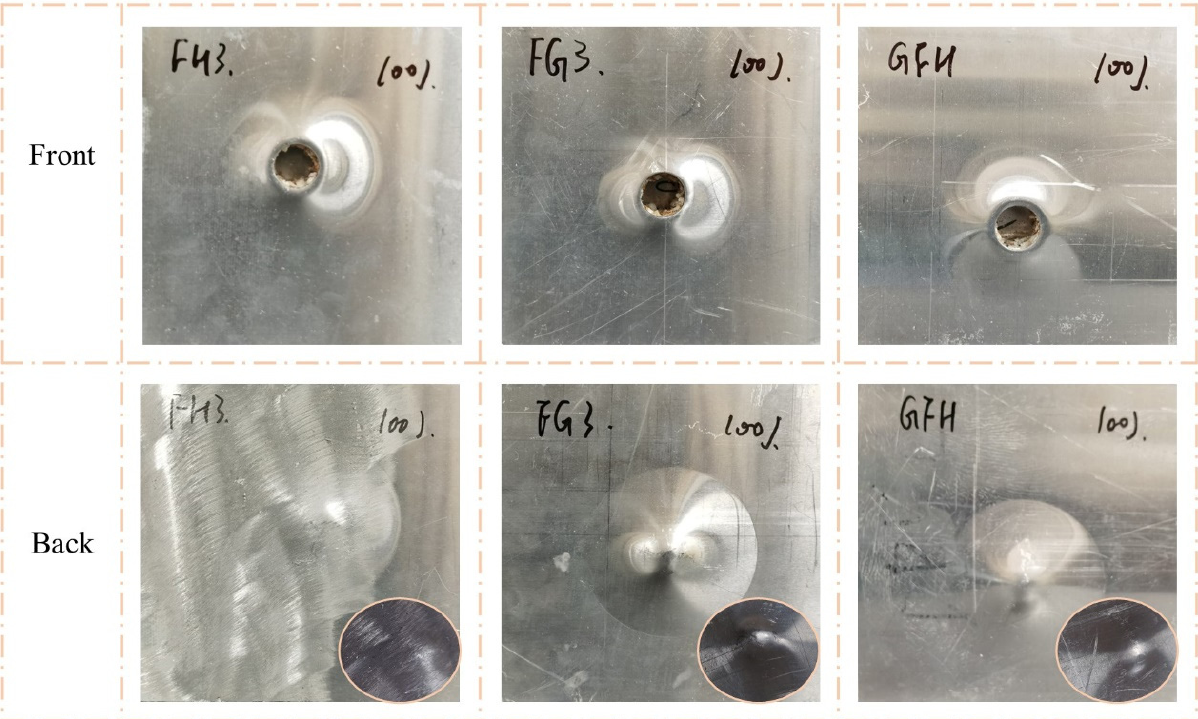
Figure 15. Damage modes of FH3, FG3, and GFH under 50 J impact energy with flat impactor.